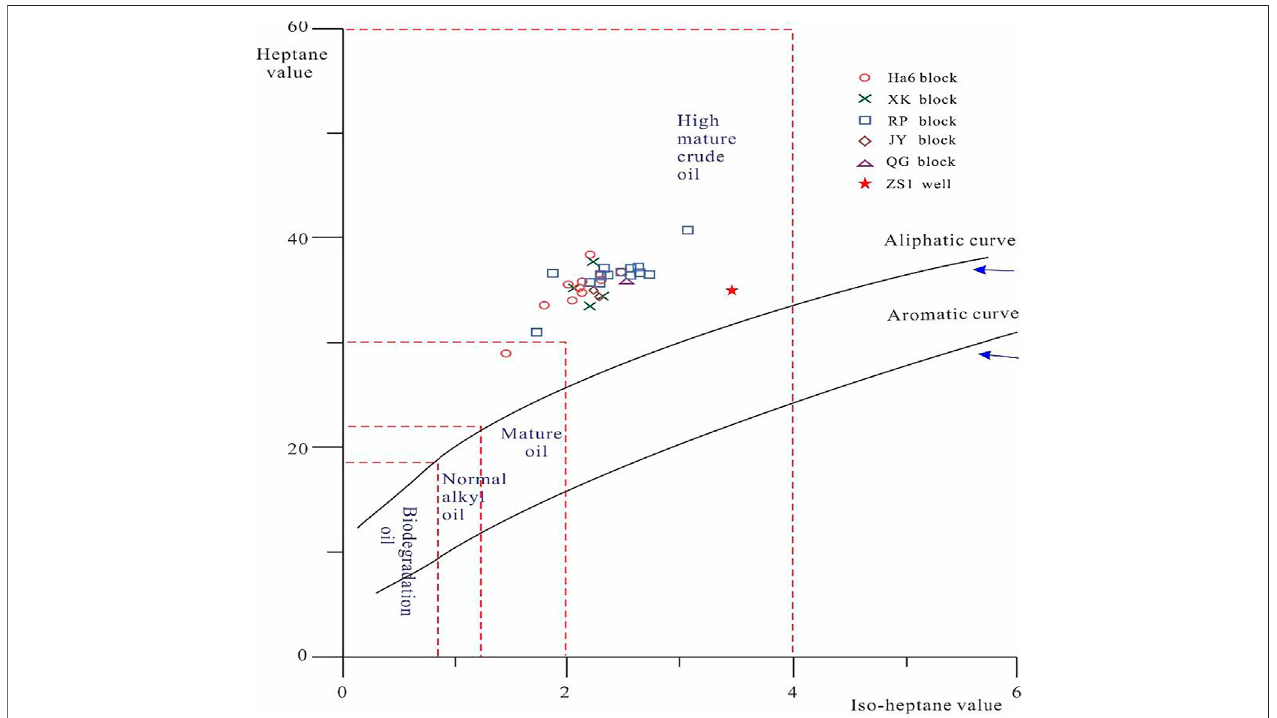
FIGURE 6 | The relationship between heptane and isoheptane values of Halahatang Ordovician crude oil.